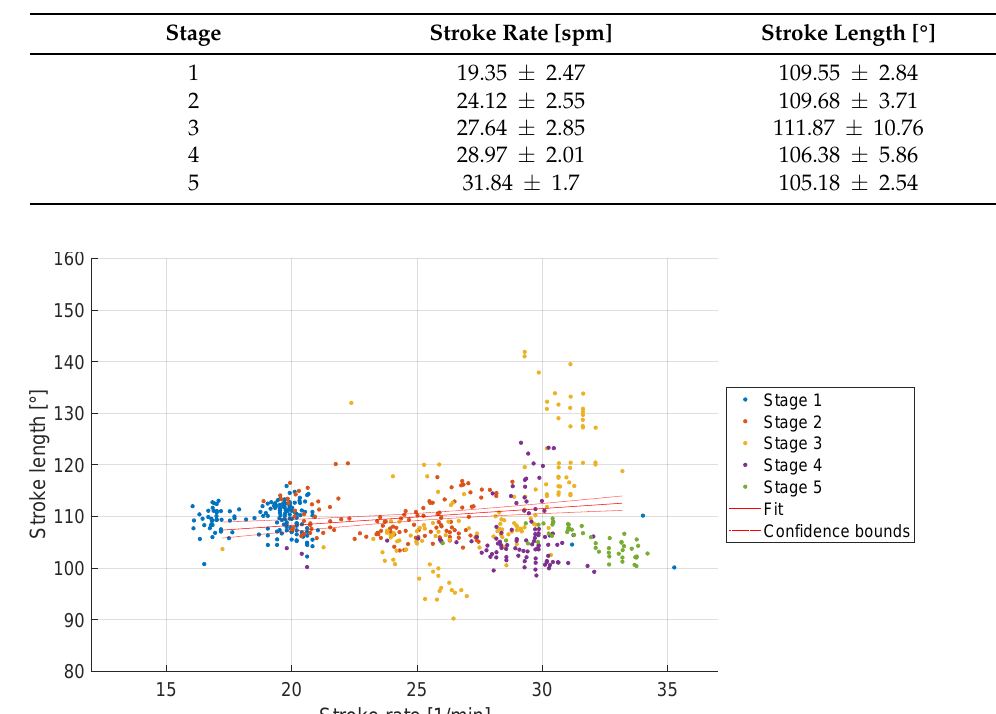
Figure 6. Minimum acceleration over stroke rate during five stage rowing training. A linear regression fit, and 95% confidence interval is marked in red. Table 4. Average and standard deviation of stroke length and stroke rate of all rowers during five load stages.